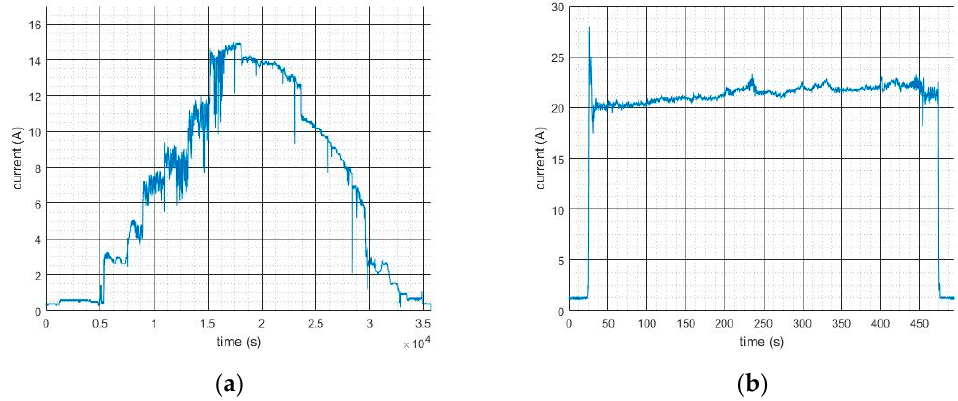
Figure 7. Current profile of PV panels and unmanned UAVs: ( a ) PV panels and ( b ) UAVs.